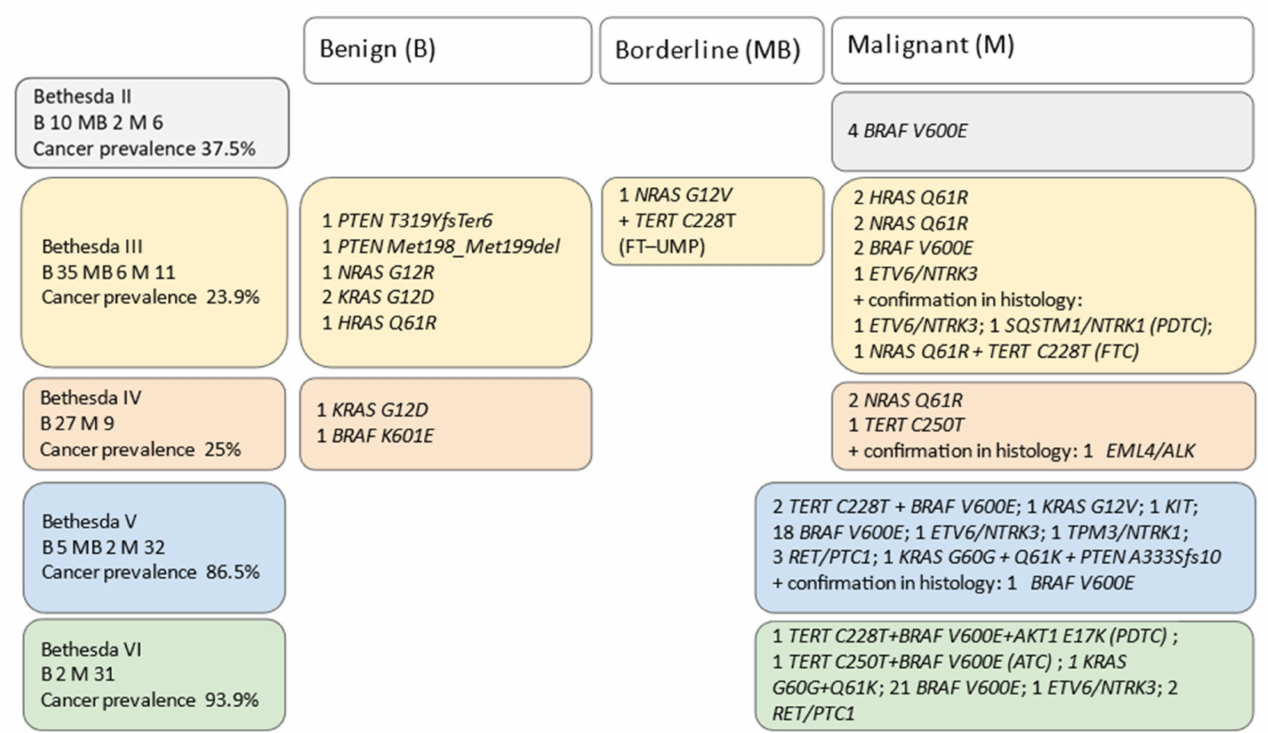
Table 2. The strongest relevant positive predictors for malignancy separately for the